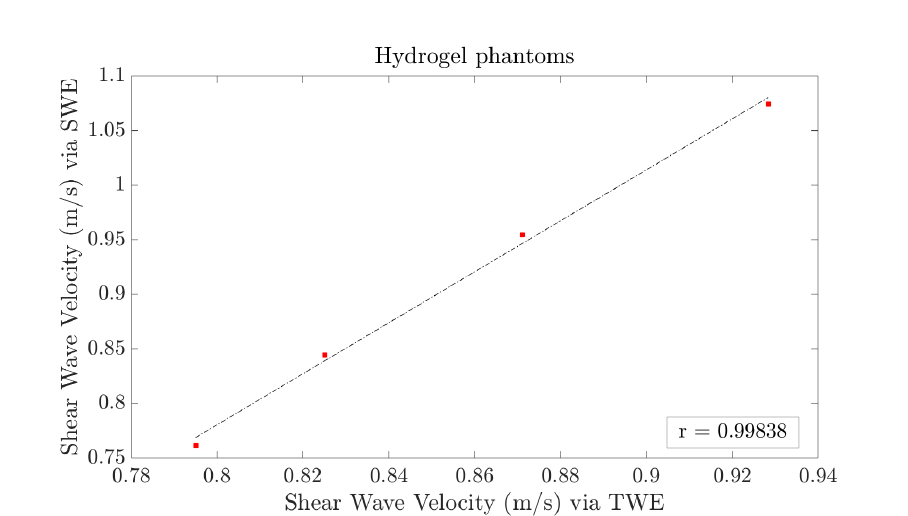
Figure 8. Pearson’s correlation between shear wave velocities via SWEI and TWE for both ex vivo liver samples ( top ) and hydrogel phantoms ( bottom ) at a frequency range from 200 to 800 Hz. Pearson correlation coefficients are 0.99767 for liver samples and 0.99838 for hydrogel